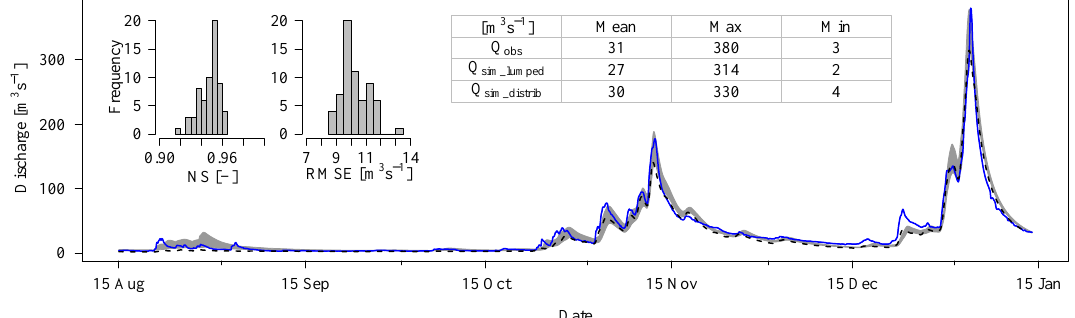
Fig. 3. Hourly hydrograph for the Upper Ourthe at Tabreux: observed (solid blue line); HBV-96 simulation using the grid-based spatially distributed version (light grey band for the 95% confidence bounds of 64 ensemble members); HBV-96 simulation using the operational spatially lumped version (dashed black line). Histograms of the Nash-Sutcliffe (NS) model efficiency coefficient and the root-mean-square error (RMSE) between the observed and the ensemble of simulated discharges using the grid-based version of HBV-96 are shown in the upper left